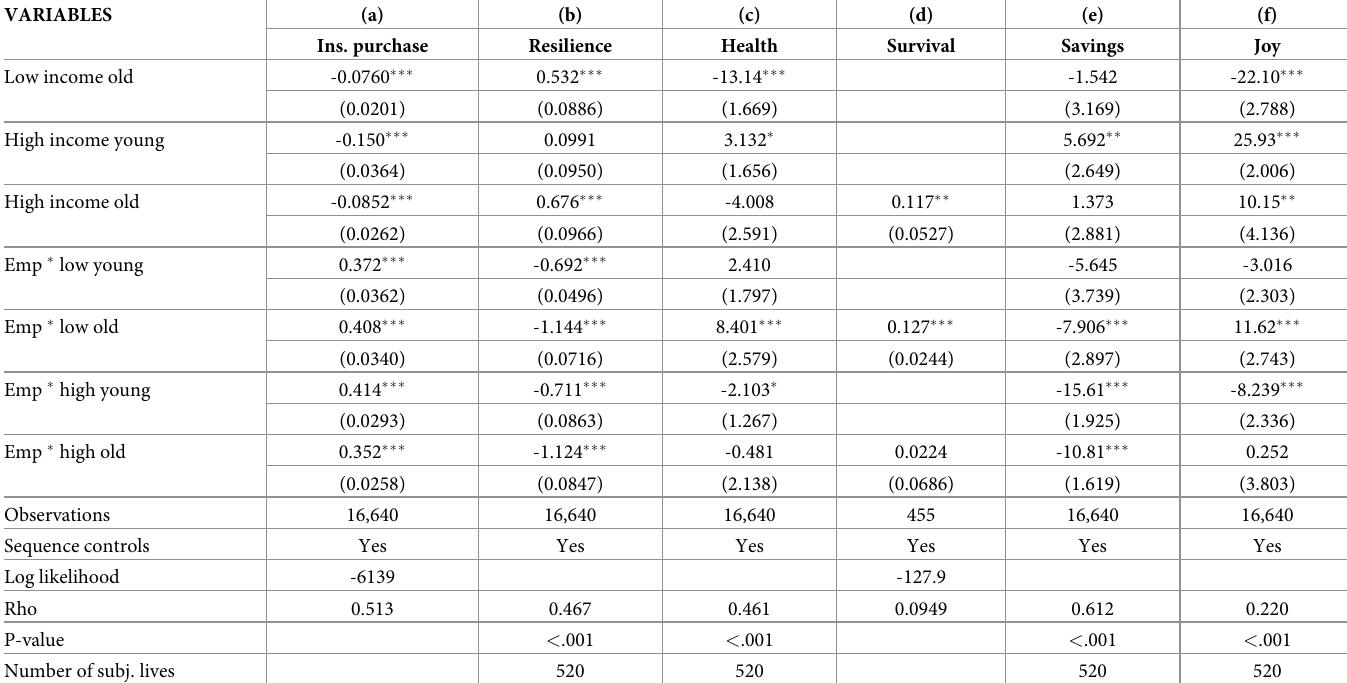
Table 3. Regression estimates for baseline differences and treatment